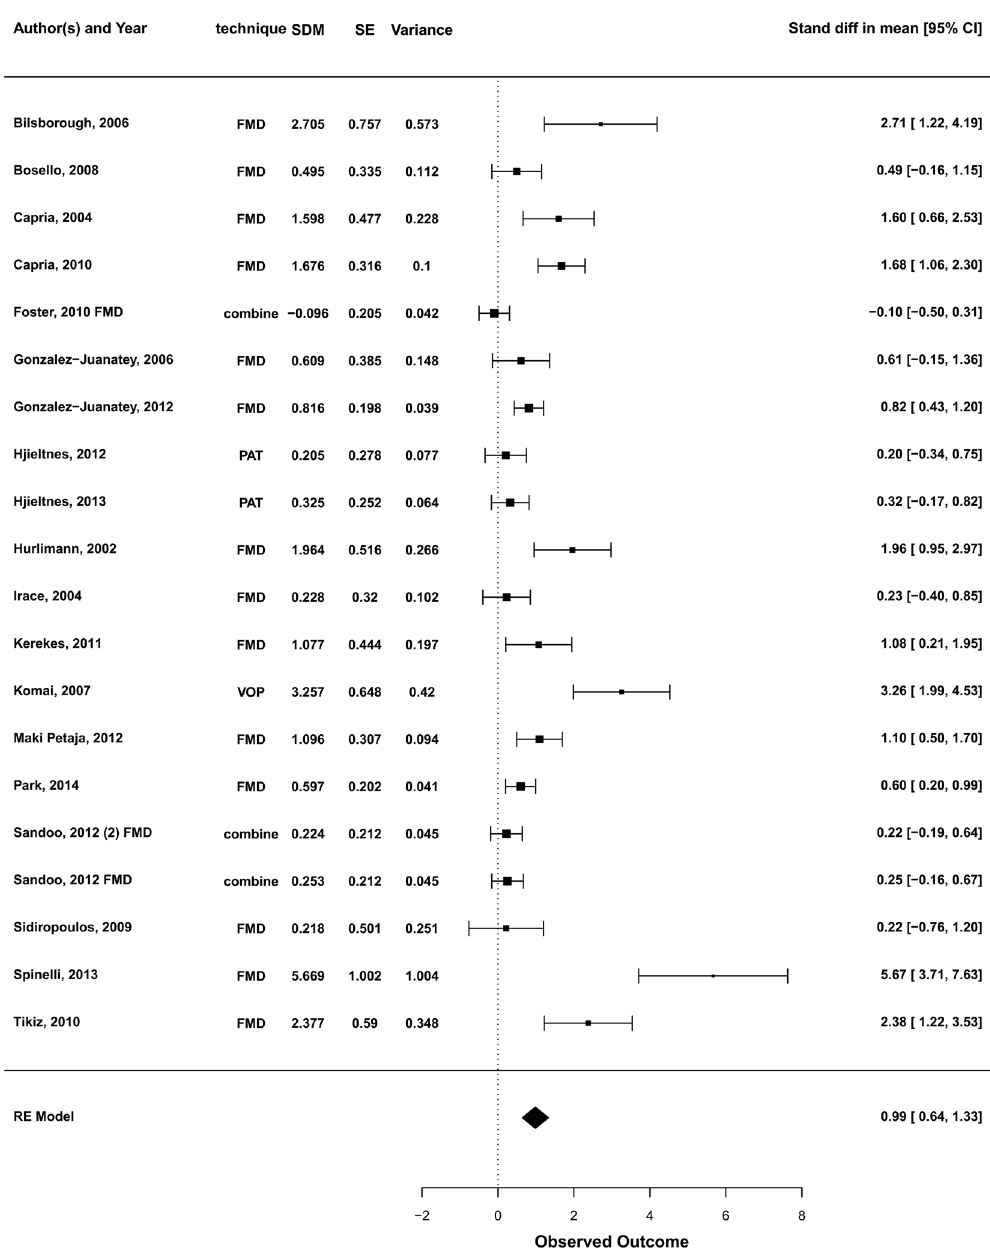
Figure 2. Forest plot for the effect of anti-TNF- α medications on measures of endothelial function. SDM, standardised difference in means; SE, standard error; CI, confidence interval; FMD, flow mediated dilatation; PAT, peripheral arterial tonometry; VOP, venous occlusion plethysmography; RE, random-effects. For those studies reporting more than one outcome for the same population and where the independence of values cannot be assumed, a combined outcome obtained by pooling FMD and LDI data was calculated in order to be more conservative regarding the precision of the point